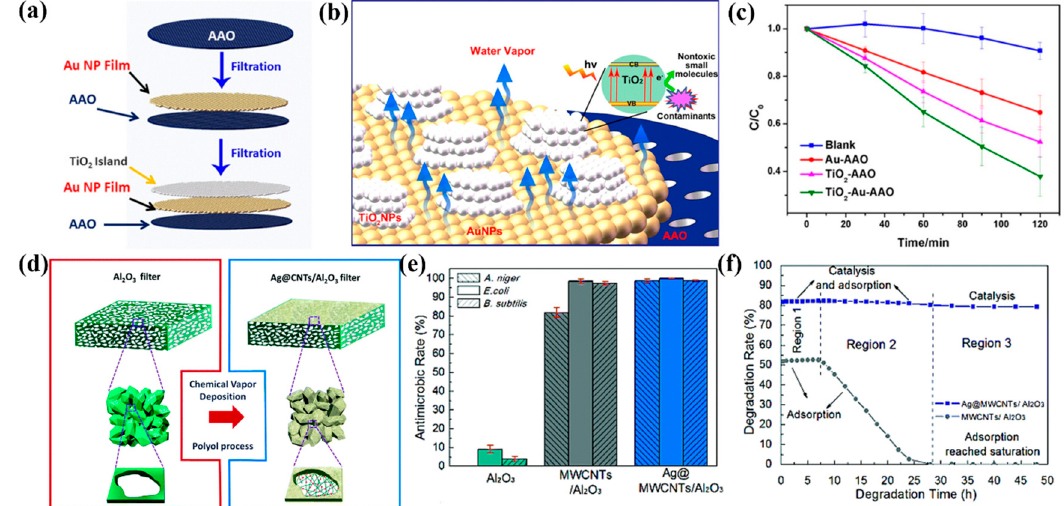
Figure 12. Membrane based PMH photocatalysts for water/air purifications. ( a ) The scheme of the fabrication of a bifunctional membrane and ( b ) the synergistic effects in the steam generation and pollutants decomposition. ( c ) The rates of degradation of RhB in Au-AAO, TiO 2 -AAO and TiO 2 -Au-AAO. ( a – c ) Reproduced with permission. [114] Copyright 2016, American Chemical Society. ( d ) The scheme for designing Ag@CNTs/Al 2 O 3 filters by chemical vapor deposition and a polyol process. ( e ) The antimicrobic rates and ( f ) degradation rates of volatile organic compounds (VOCs) in different purification filters. ( d – f ) Reproduced with permission. [124] Copyright 2017, the Royal Society of Chemistry.